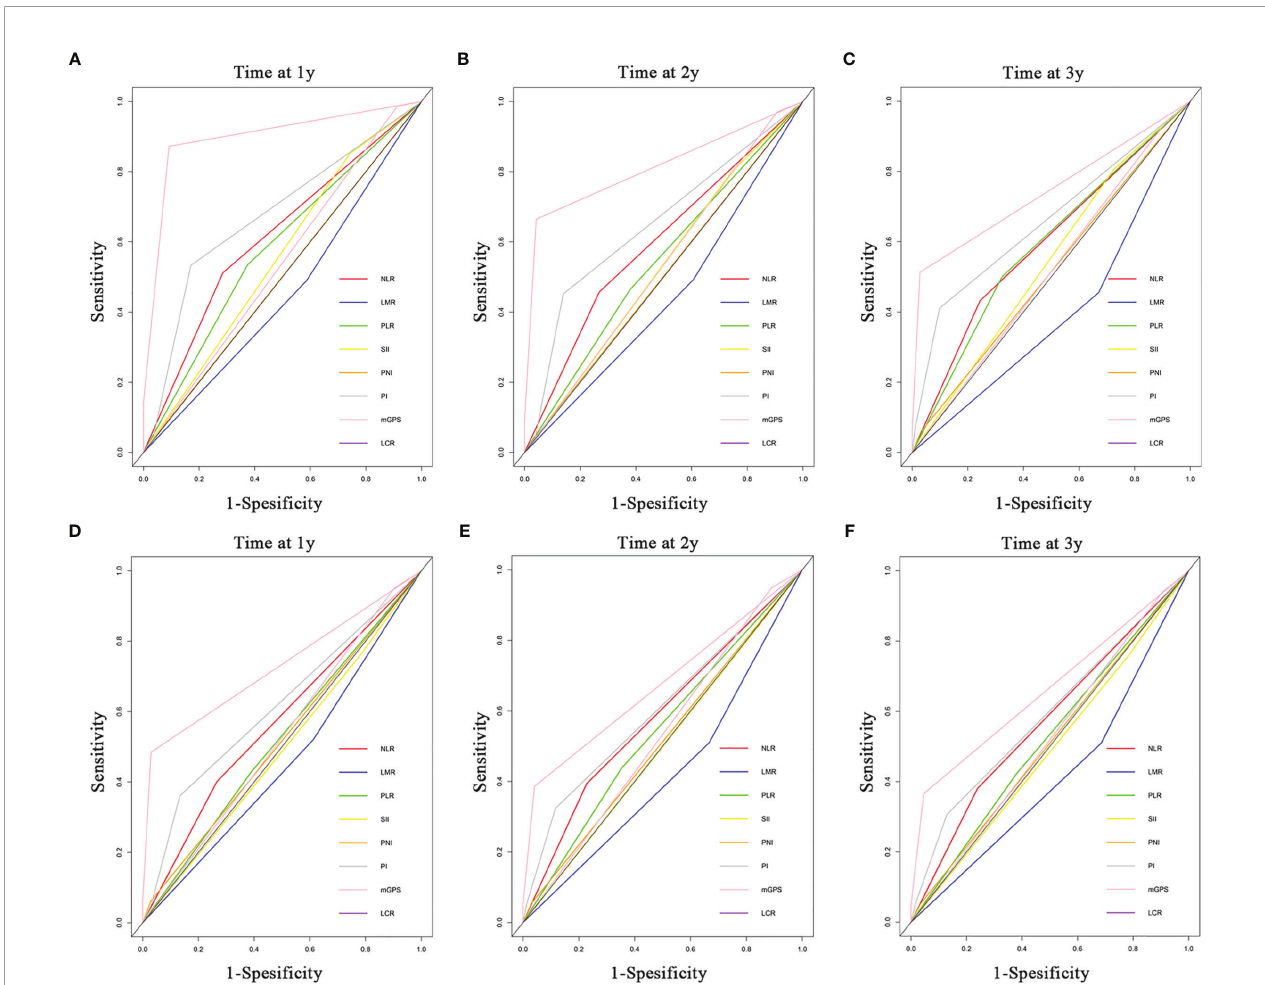
FIGURE 4 | Comparisons of the ROC curves for OS and PFS in the SYSUCC cohort among the in fl ammation-based score systems. ROC curves of OS at 1 (A) , 2 (B) , and 3 years (C) . ROC curves of PFS at 1 (D) , 2 (E) , and 3 years (F)